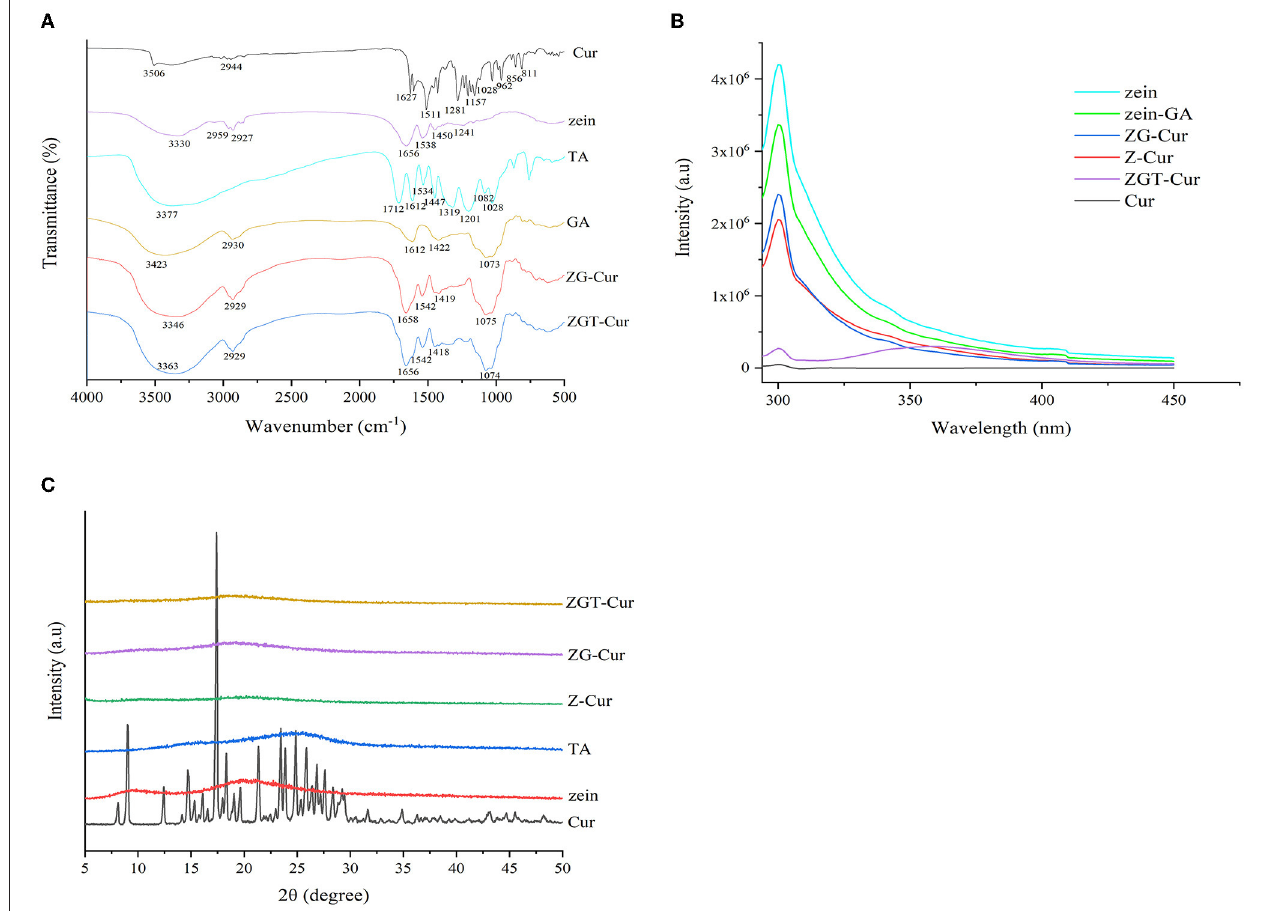
FIGURE 8 | Fourier transform infrared (A) , fluorescence spectrums (B) , and X-ray diffraction (C) spectra of the materials used to prepare the ZGT-curcumin (Cur) particles.